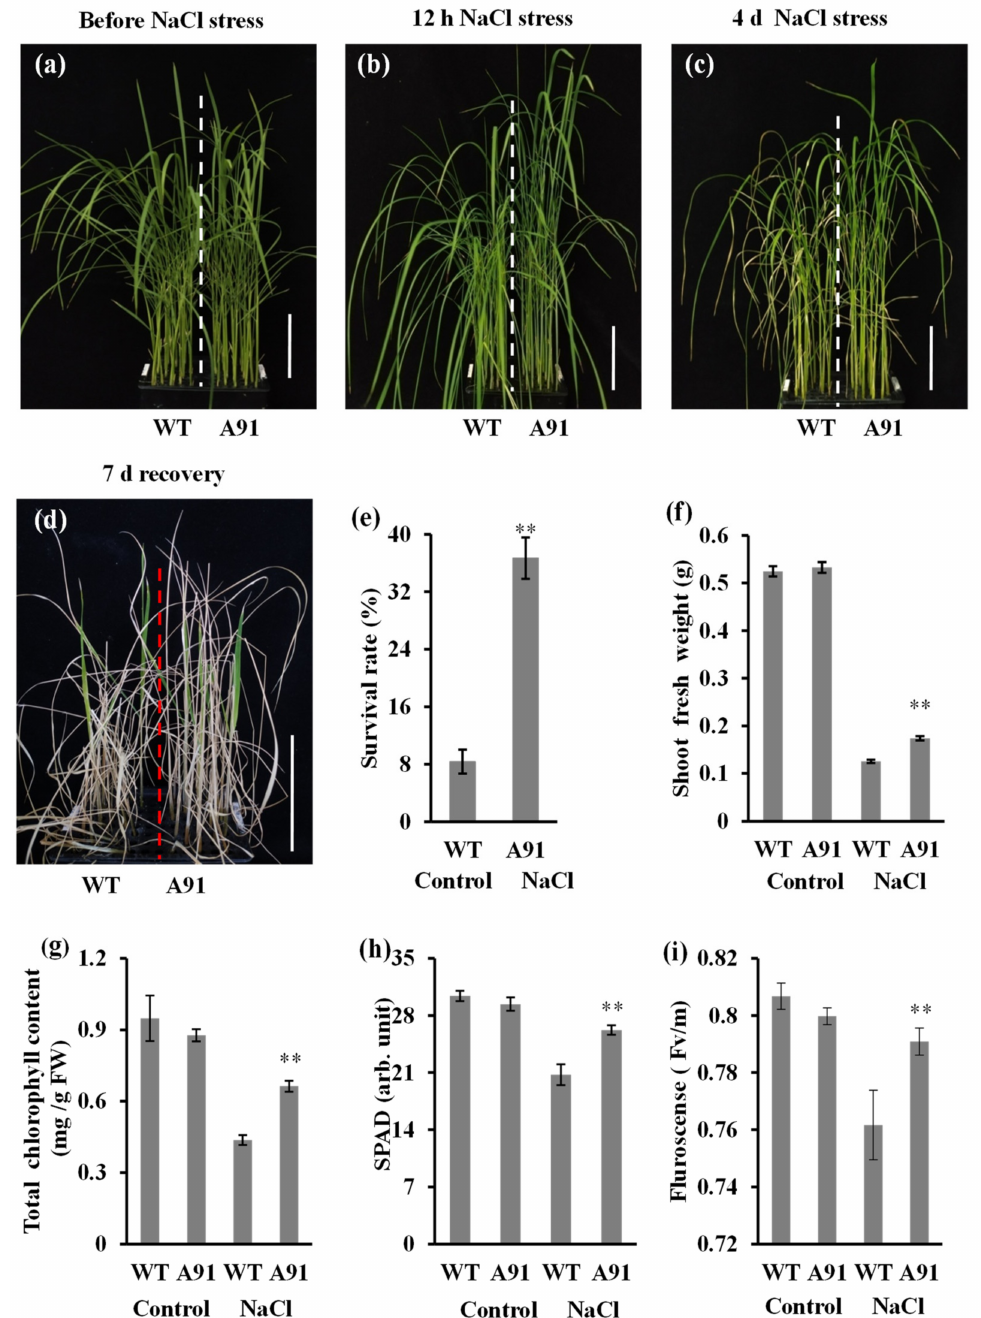
Figure 4. The growth characteristics of the A91 and WT exposed to salt stress treatments (0 and 150 mM NaCl). ( a ) The growth of 21-day-old seedlings before salt stress; ( b ) the growth of 21-day-old seedlings after 12 h stress; ( c ) the growth of 21-day-old seedlings after 4 days of stress; ( d ) 7 days recovery after 7 days of salt stress; ( e ) the survival rate after 7 days of recovery; ( f ) the fresh shoot weight after 7 days of stress; ( g ) total chlorophyll content; ( h ) SPAD value; ( i ) fluorescence; n = 3 bio- logical replicates ( e , f , each replicate represented 20 seedlings); 3 biological replicates ( g ), 9 biological replicates ( h , i ); data represented as means ± SE; ** indicates significant t -test results at p < 0.01; scale bar 10